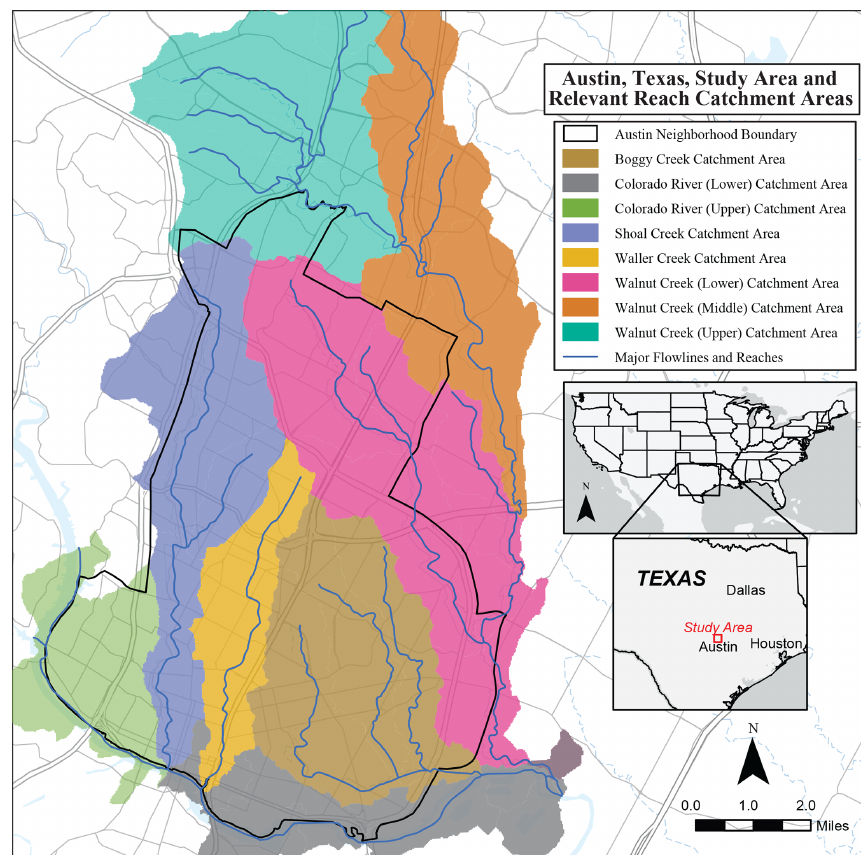
Figure 1. Austin, Texas, study area boundary and relevant stream reach catchment